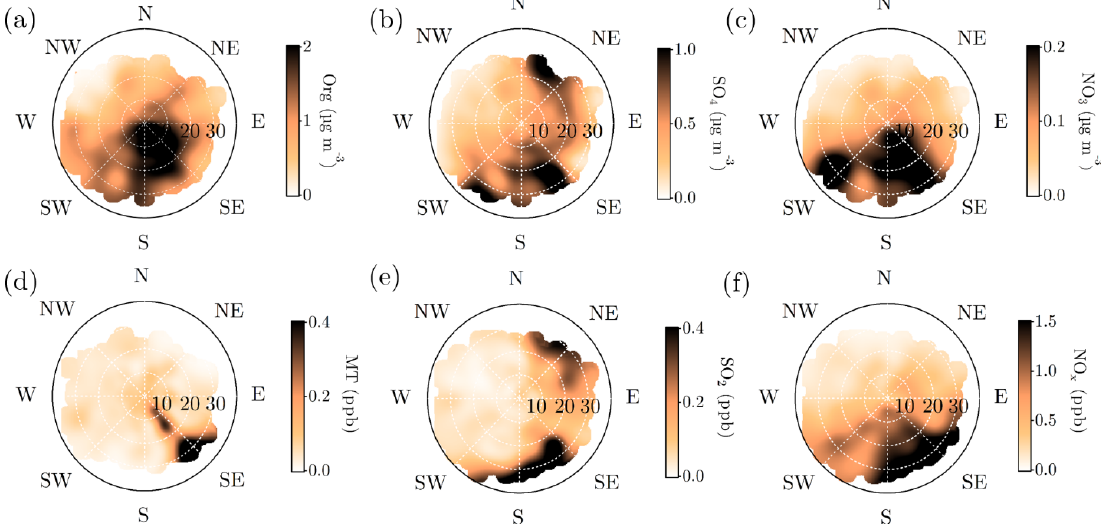
Figure 9. Openair polar plots for organic aerosol (a) , sulfate (b) , nitrate (c) , monoterpenes (d) , SO 2 (e) , and NO x (f) . The distances from the origin indicates wind speeds inkmh − 1 . The wind speed grid lines are presented with dashed white circles. The color scales represent the concentrations observed with each wind speed and direction combination. As the figures do not indicate any likelihood of the wind speed and distance combinations, Fig. A1 is important to keep in mind while interpreting them. Briefly, N–NE–E is the least probable wind direction, whereas S–SW–W is the most likely. Wind speeds generally stay below 20kmh − 1